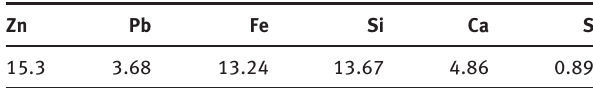
Table 1: Chemical composition of the zinc oxide ores (wt.%). Zn